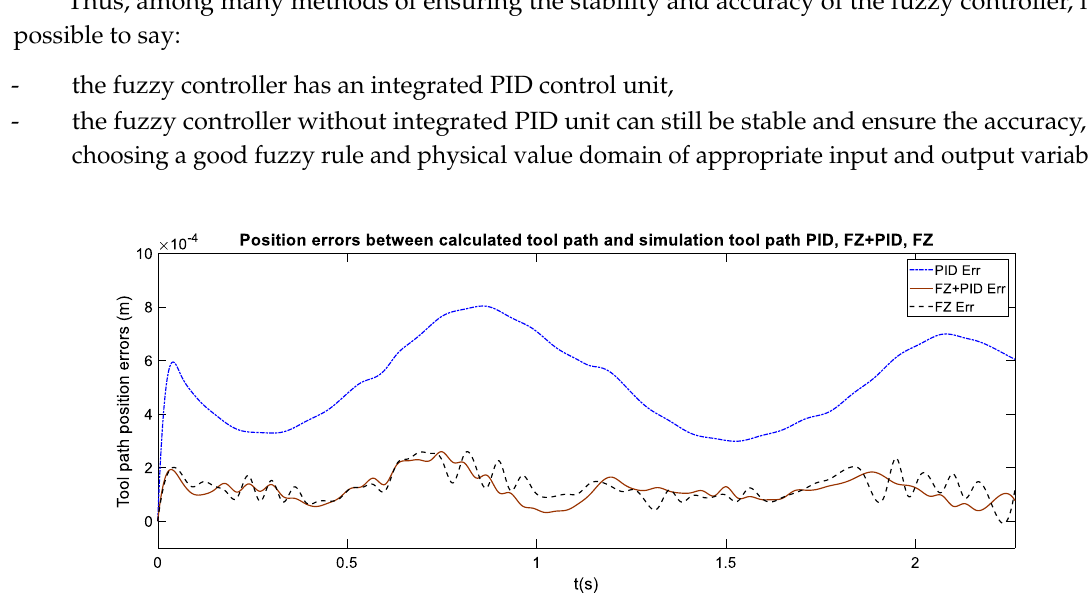
Figure 20. Tool path position errors between desired value and simulation result in cutting force mode increases by 50% due to noise.